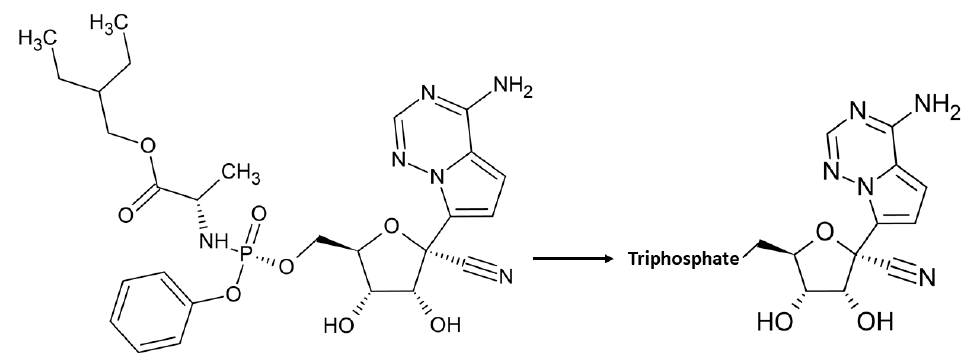
Figure 4. Chemical structure of Remdesivir (GS-5734) and its pharmacologically active nucleoside triphosphate NTP.